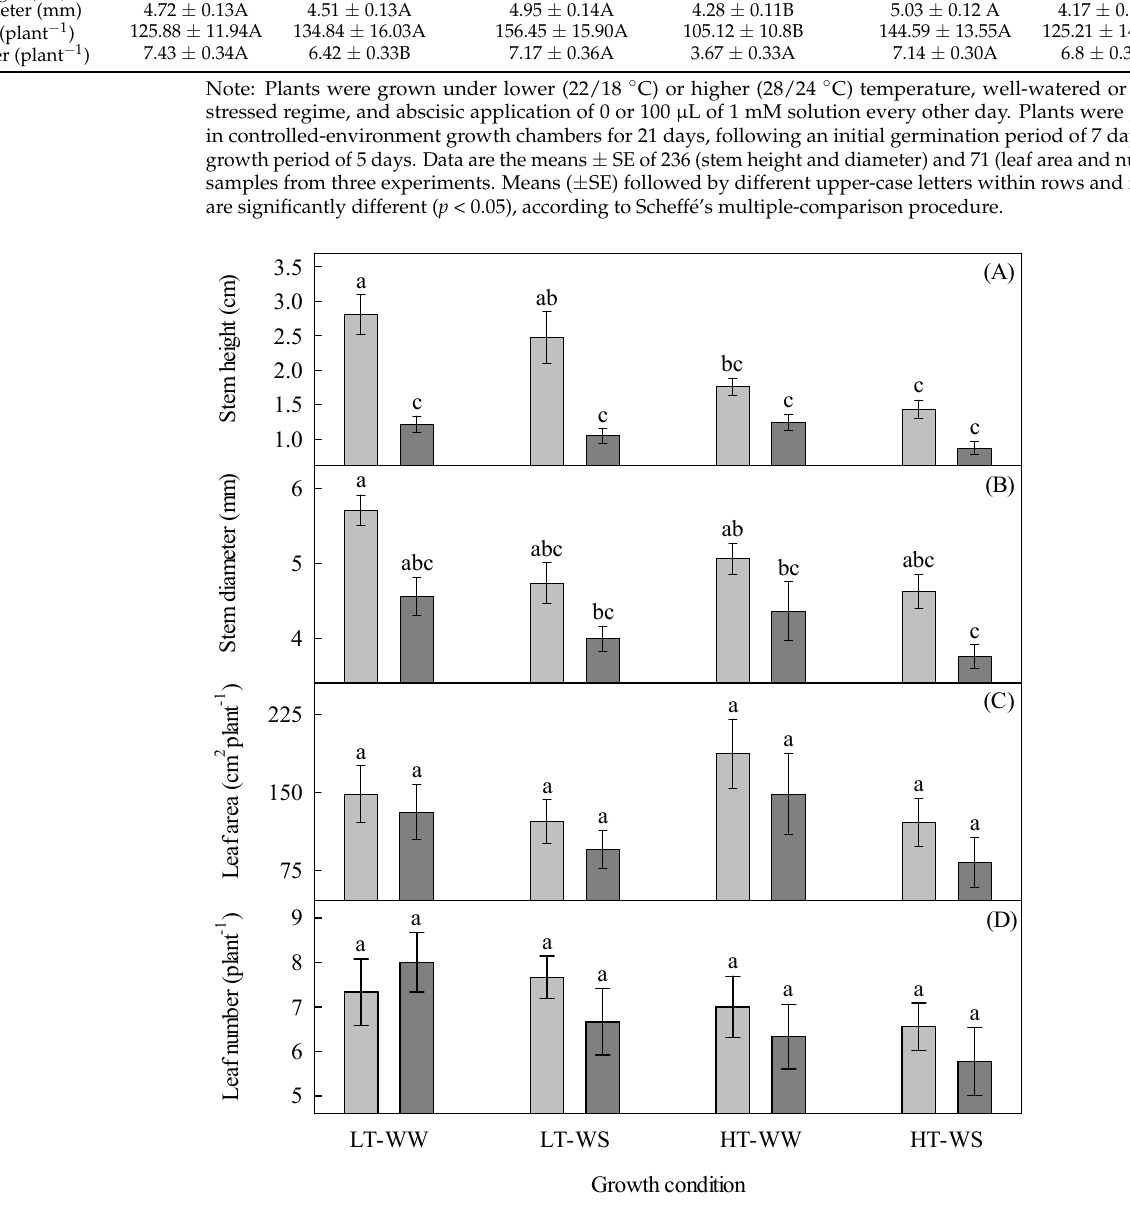
Figure 1. Growth of 33-day-old tomato plants grown under eight experimental conditions including two temperature regimes, two watering regimes, and two abscisic acid concentration applications after 12 days of initial germination and growth in growth chambers with lower temperature, watering to field capacity, and without abscisic acid application. ( A ) Stem height, ( B ) stem diameter, ( C ) leaf area, and ( D ) leaf number. LT, lower temperature; HT, higher temperature; WW, well-watered; WS, water-stressed; light gray, no abscisic acid; dark gray, abscisic acid. Data are the means ± SE of 236 (stem height and diameter) and 71 (leaf area and number) samples from three experiments. Bars with different letters above them are significantly different, according to Scheff é ’s multiple comparison procedure at the 5% confidence level.